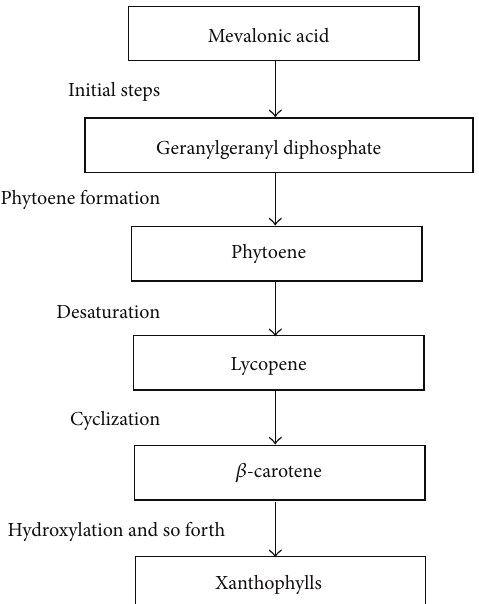
Figure1:Flowchartsummaryofthecarotenoidsbiosynthesisstages. Reference: Britton et al.